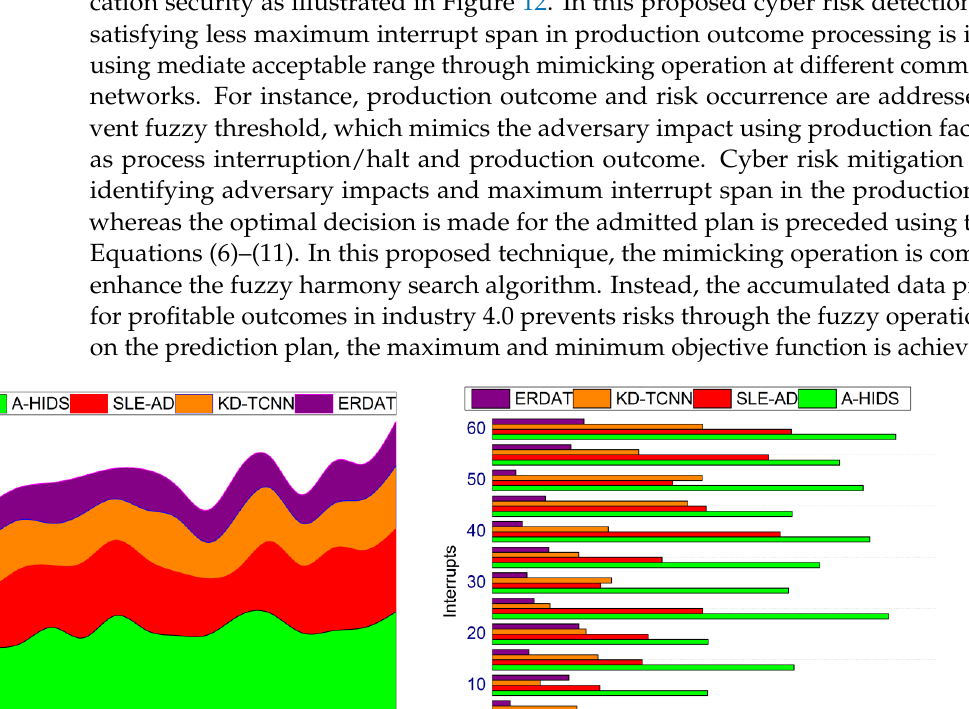
Figure 11. Halted Schedules. ( a ) Halted Schedules. ( b ) Iterupts.